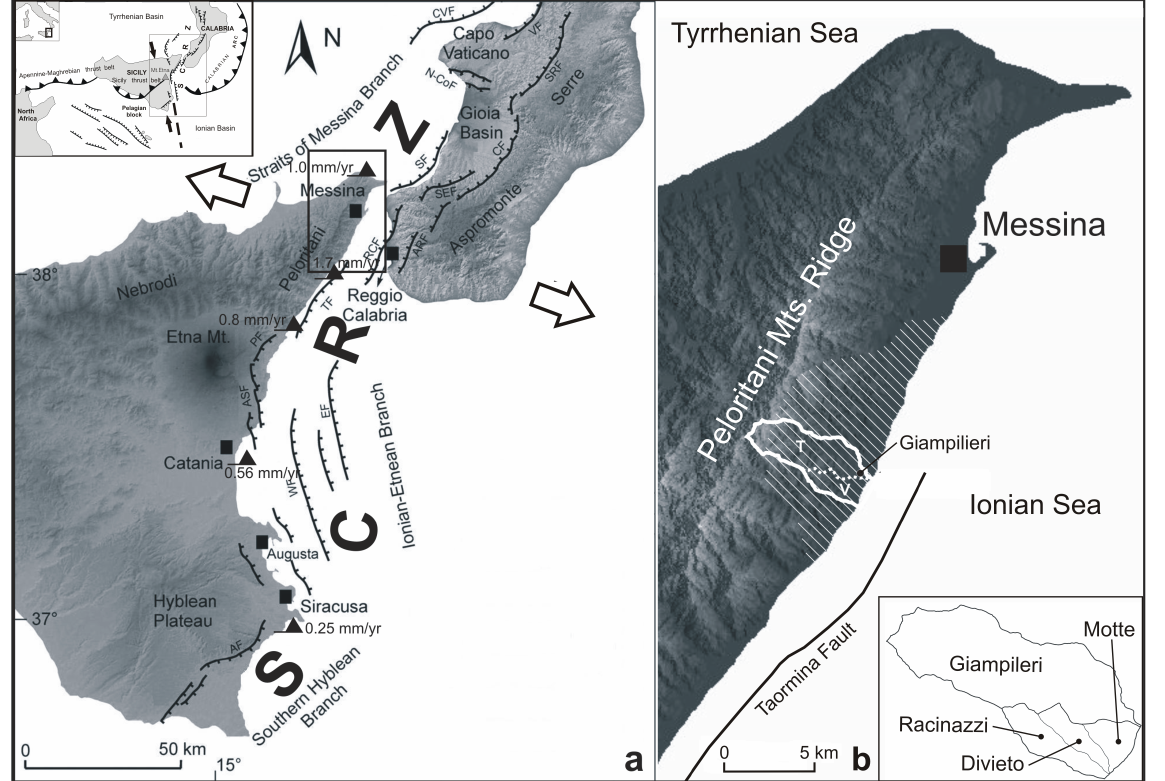
Fig. 1. (a) Tectonic map of eastern Sicily and southern Calabria showing the Siculo–Calabrian Rift Zone (SCRZ), modified from Catalano et al. (2008). Arrows indicate the regional extension direction and triangles the uplift rates given by Catalano et al. (2003) and Catalano and De Guidi (2003); RIF: Rosolini–Ispica faults; AV: Avola fault; WF: western Ionian fault; EF: eastern Ionian fault; ASF: Acireale–S.Alfio faults; PF: Piedimonte fault; TF: Taormina fault; RCF: Reggio Calabria fault; AF: Armo fault; SF: Scilla fault; SEF: S.Eufemia fault; CF: Cittanova fault; SRF: Serre fault; VF: Vibo fault; CVF: Capo Vaticano fault; N-CoF: Nicotera–Coccorino faults. (b) the hatched zone represents the area affected by landslides on the 1st October 2009; the continuous white line indicates the study area; training area (T) and validation area (V) of the landslide susceptibility analysis are